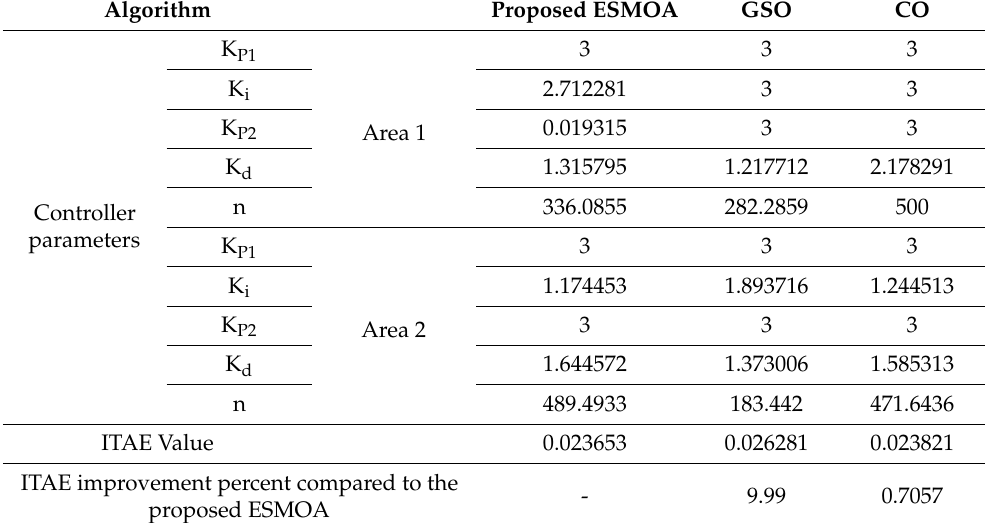
Table 5. Results for Case 2.